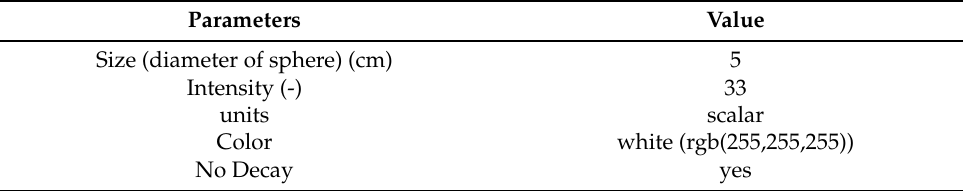
Table 3. Parameters set for V-Ray Sphere